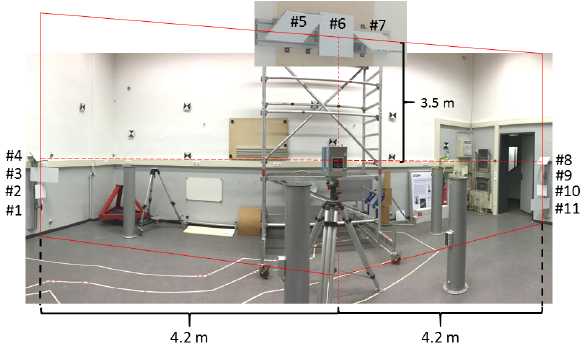
Figure 3. Calibration environment with eleven adjustable reference planes in a laboratory at the Geodetic Institute